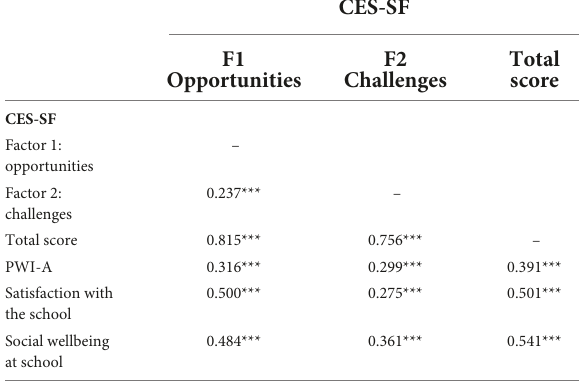
TABLE 4 Correlations between CES-SF and comparison